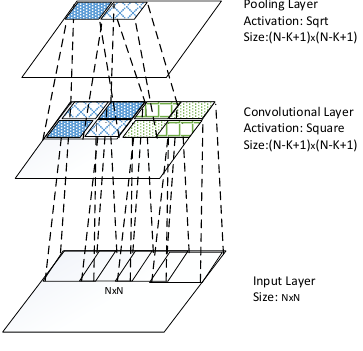
Figure 5. Architecture of TICA network.